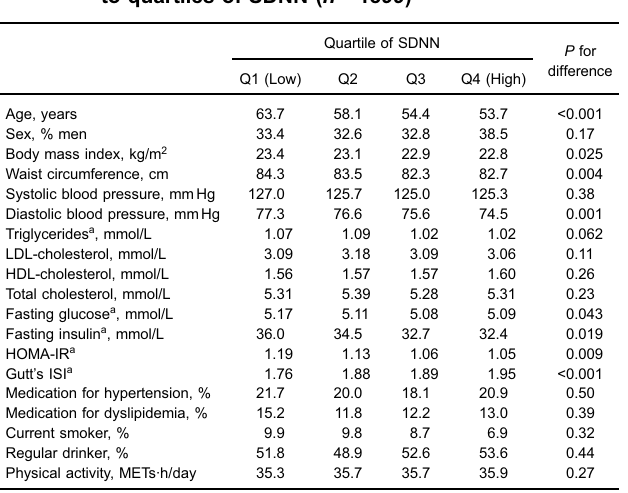
difference Q1 (Low)